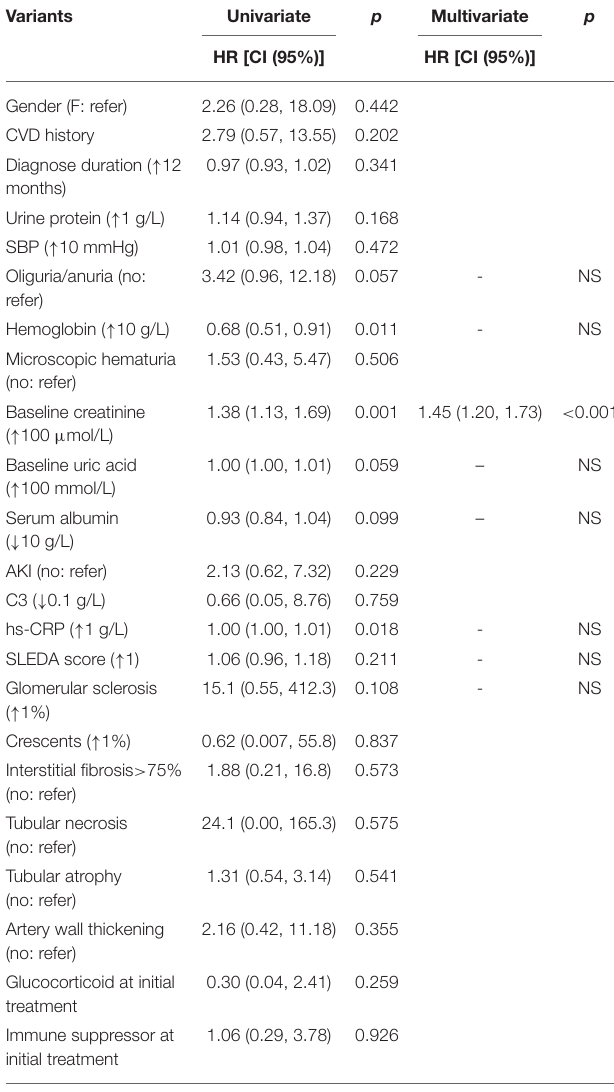
TABLE 6 | Predictors of kidney survival in patients with late-onset LN. Variants Univariate p